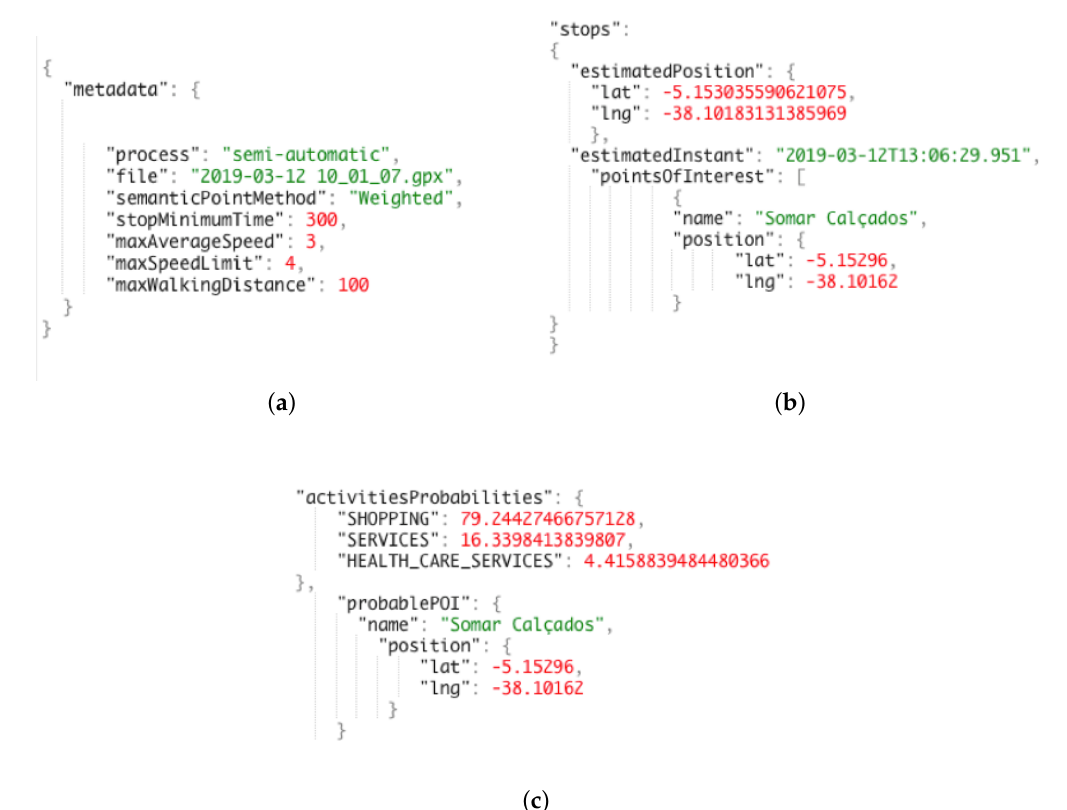
Figure 11. Semantic Trajectory Example: ( a ) Metadata on the methods used for enrichment. ( b ) Set of identified stops. ( c ) Semantic information on activities and the POI likely to be visited.